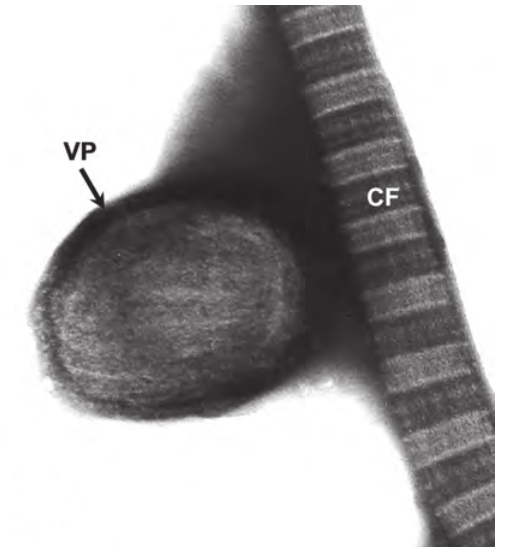
FIG. 6 Crocodile poxvirus particle attached to a collagen fibre from the crust covering a newly formed cyst. CF – col- lagen fibre; VP – virus particle, 40